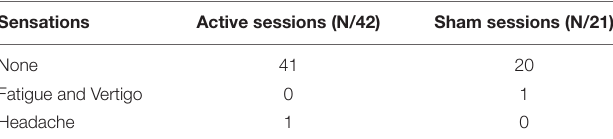
TABLE 2 | Discomforts in